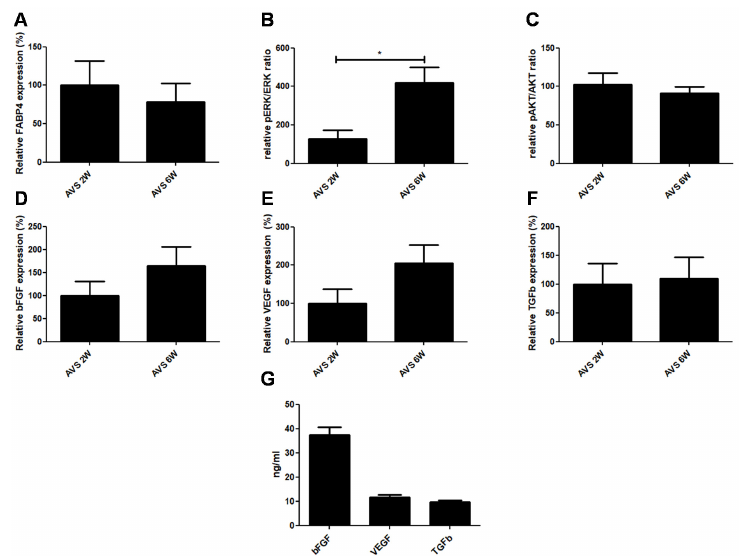
Figure 9. Expression of adipogenesis, proliferation markers and growth factors. ( A ) FABP4 mRNA expression of vascularized mSVF explants after two and six weeks. There was no difference in FABP4 mRNA expression between two and six weeks. ( B ) pERK/ERK and (C ) pAKT/AKT ratios in vascularized mSVF explants after two and six weeks. While no difference in phosphorylation of Akt was seen, activation of pERK1/2 was significantly increased after six weeks. After two and six weeks, there was no statistical difference in the mRNA expression of ( D ) bFGF , ( E ) VEGF, ( F ) TGFb in vascularized mSVF. ( G ) When cultured, mSVF secreted significant amounts of VEGF, bFGF and TGFb. * p < 0.05.